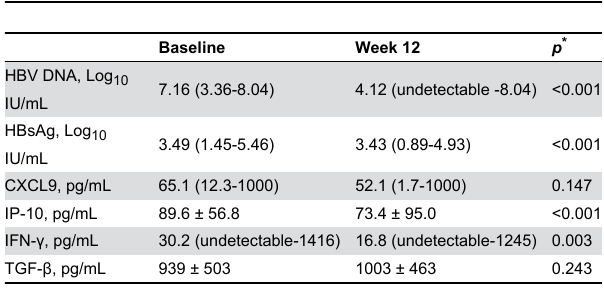
Table 2. Dynamic changes of HBV viral load, HBsAg and cytokine/chemokine levels in CHB patients at baseline and week 12 of PEG-IFN therapy.